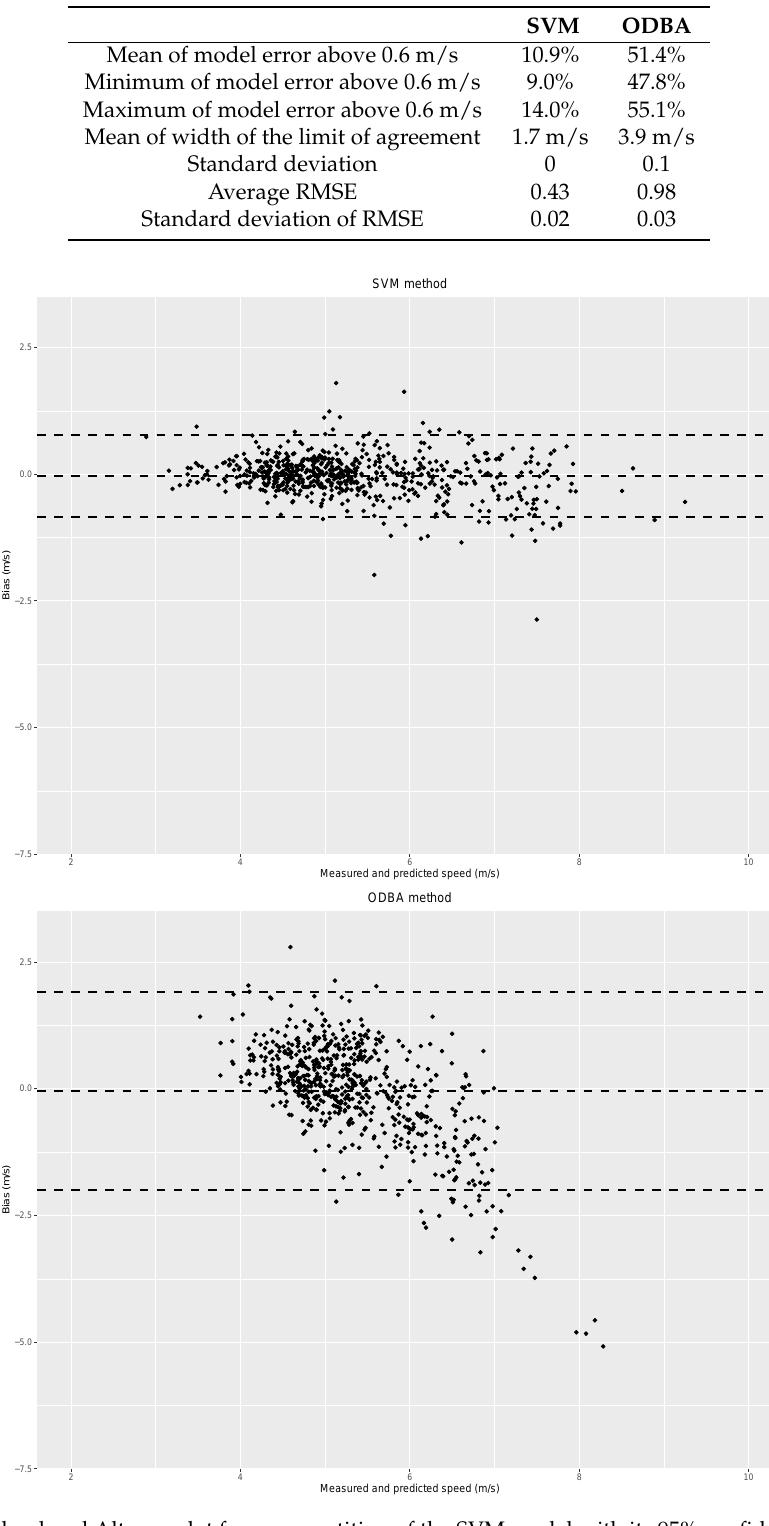
Figure 6. Bland and Altman plot for one repetition of the SVM model with its 95% confidence interval ( top ) and the overall dynamic body acceleration (ODBA) method ( bottom